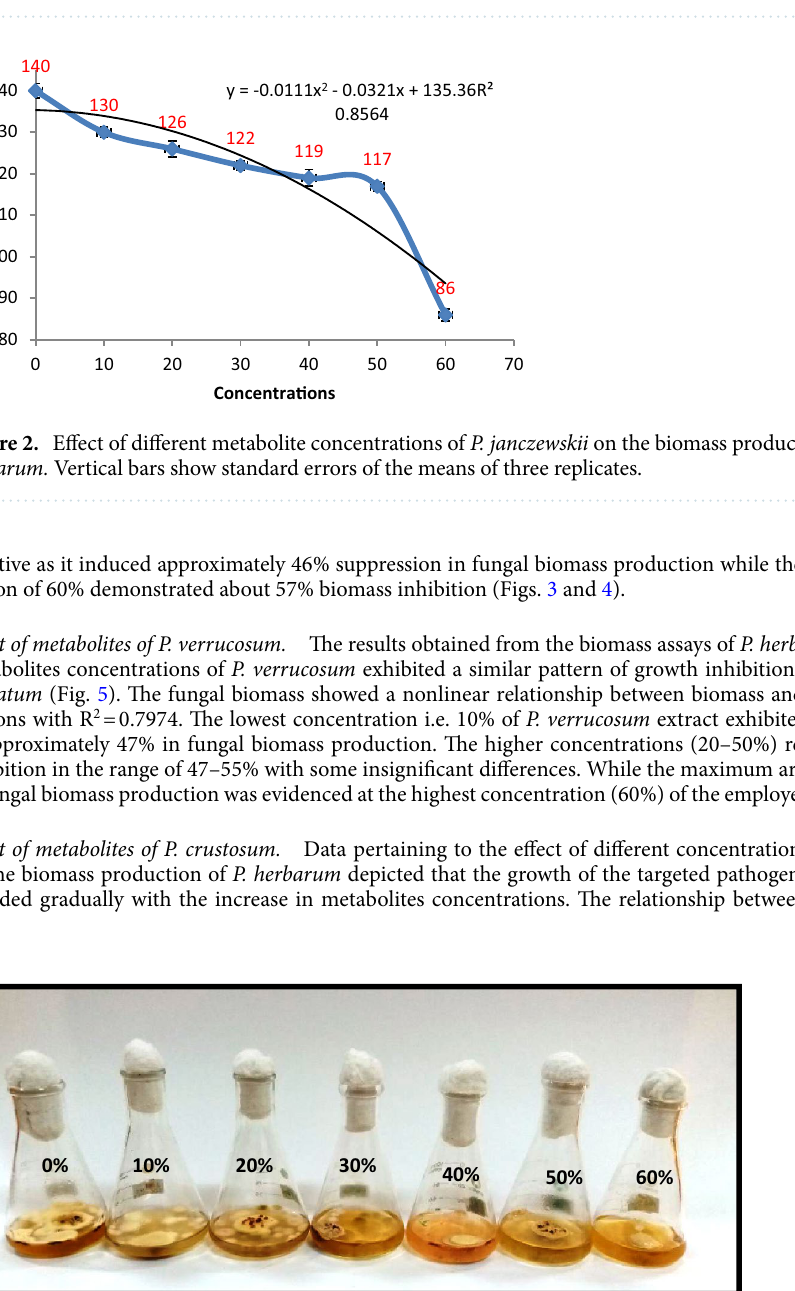
Figure 1. Effect of metabolite concentrations of P. janczewskii on the growth of P. herbarum.